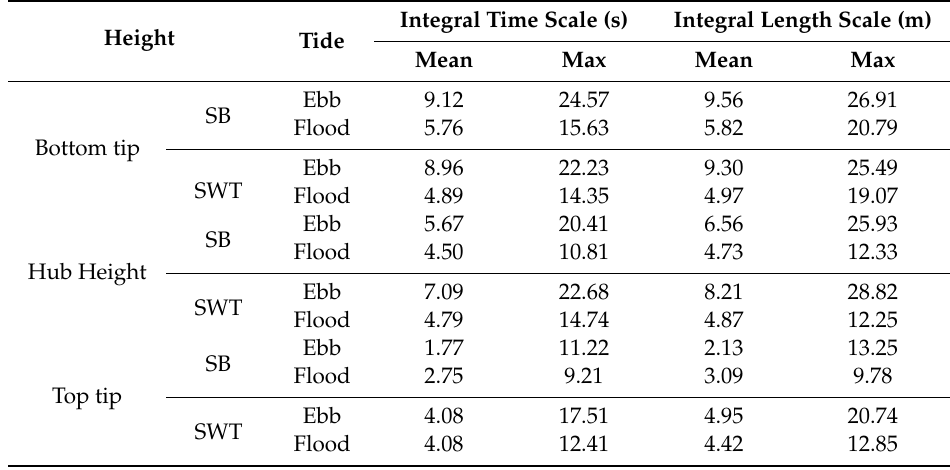
Table 6. Integral time and length scales from CTb3 estimated for ebb and flood tides based on streamwise velocity fluctuations obtained after the SB and the SWT